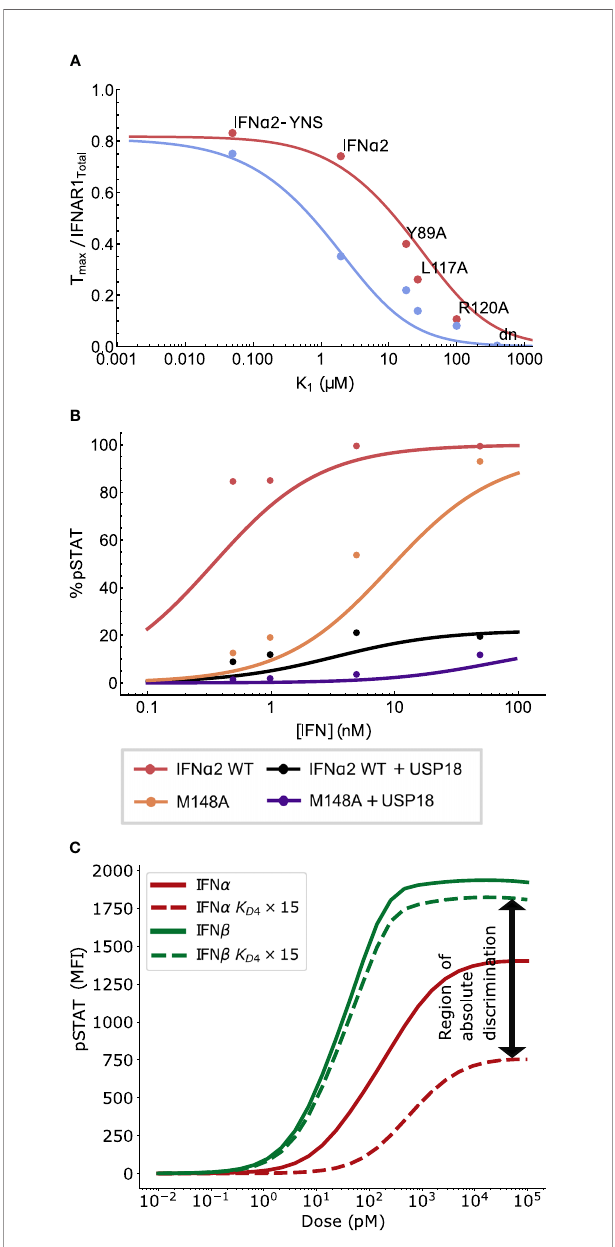
FIGURE 5 | Long time deactivation via USP18 regulates receptor complex stability to achieve absolute discrimination. (A) Measurements reproduced from (10) of ternary complex formation in un-primed cells (red, also see Figure 2A ) and cells primed with IFN to express USP18 (blue). Primed cells were observed to form fewer ternary complexes relative to unprimed cells. This reduction can be explained by a 15-fold increase in K4 in our analytic model (blue curve, produced from Equation 1); see text. (B) pSTAT1 Western blot band intensities for wild-type (WT) IFN a 2 with and without USP18 expression, and IFN a 2-M148A with USP18 expression are reproduced from (10). USP18 inhibition was modeled by a 60-fold increase in K 4 in Eq. 4 (lines); see text. (C) The simulated effect of USP18 on the pSTAT response at 60 minutes for IFN a 2 (red) versus IFN b (green). Solid lines show the un-primed response while dashed lines show the effect of a 15-fold increase in dissociation rate, consistent with the effect of USP18 (reported to be between 15- to 60-fold change depending on cell type). The differential refractoriness of IFN a 2 as compared to IFN b greatly enhances the region of absolute discrimination (difference in pSTAT max